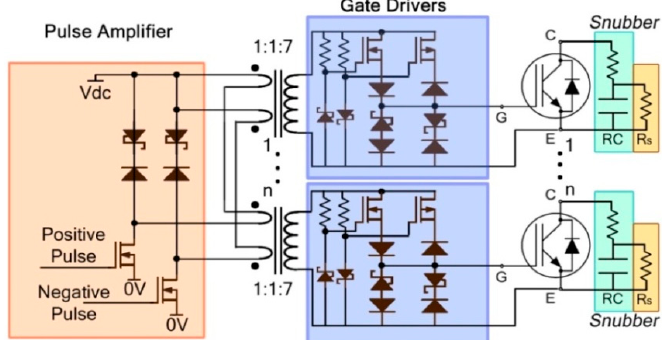
Figure 7. Breakdown of the firing circuit with synchronous rectifier, single and double primary magnetic link, based on the thyristor firing concept.